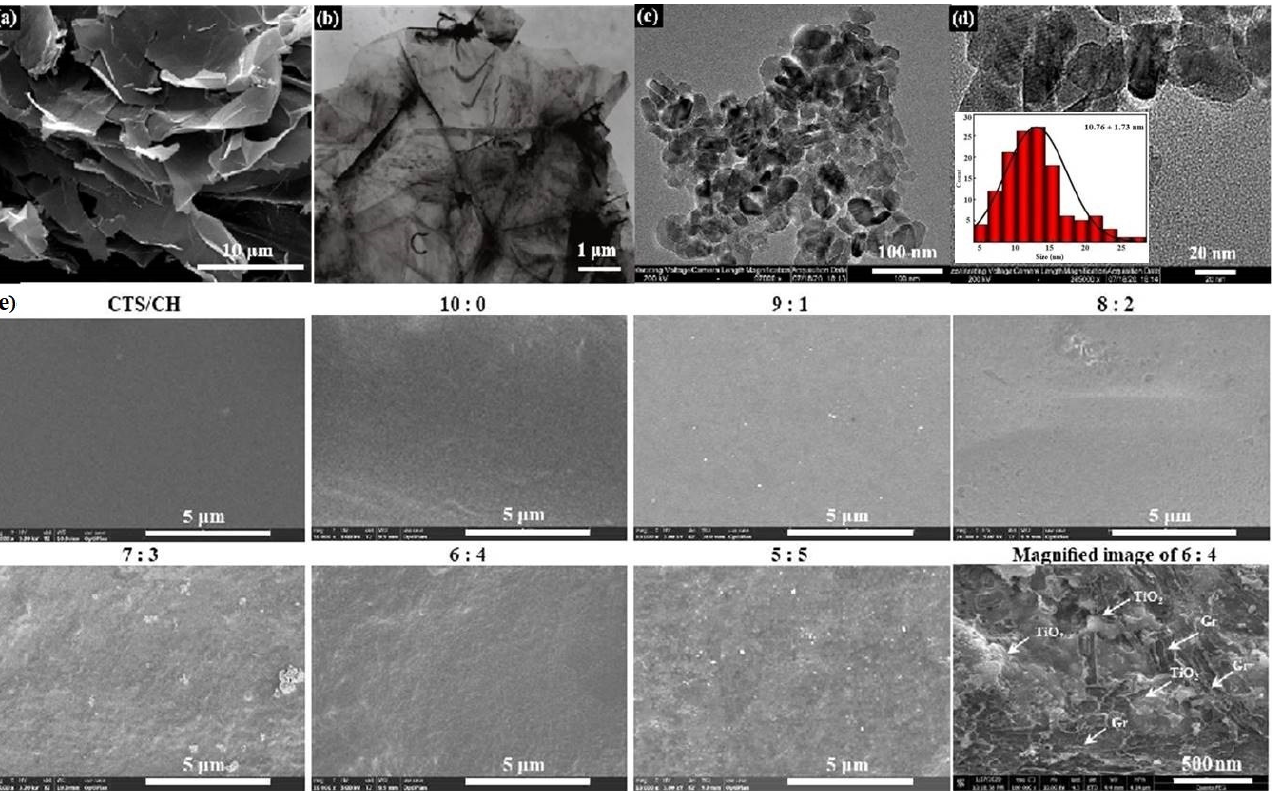
Figure 1. ( a ) SEM and ( b ) TEM images of Gr powder, ( c ) and ( d ) TEM images of TiO 2 NPs, and ( e ) typical SEM images of the different composite films fabricated at an ultrasonic power of 160 W. These results confirm the good dispersibility of TiO 2 NPs in the CTS/CSH matrix, while the zeta potential value of the precursor solution obtained at an ultrasonication power of 160 W was −14.33 ± 0.45 mV (Table 1). However, at a TiO 2 :Gr ratio of 9:1, the dispersion stability significantly decreased, and the precursor solution separated into three different layers: a clear upper layer, a lightly colored middle layer corresponding to a uniform CTS/CSH/TiO 2 /Gr dispersion, and a deeper colored lower layer containing precipitated TiO 2 /Gr particles. The relatively small amount of added Gr limits its expansion. This phenomenon caused a significant drop in the solution zeta potential to −10.31 ± 0.13 mV and decreased the stability of the system. Upon increasing the Gr content, the upper layer contained a very small amount of a clear liquid after 24 h of storage, while the black (due to the high Gr content) lower layer essentially consisted of the CTS/CSH/TiO 2 /Gr dispersion. The results revealed that the stability of the precursor solution toward a separation increased with an increasing Gr content, which was accompanied by the increase in its zeta potential values [17]. This behavior was attributed to the ability of Gr to undergo expansion in aqueous solutions and the wrapping of the TiO 2 NPs, thus increasing their dispersibility. Furthermore, the ultrasonic treatment strongly influenced the dispersion stability of the TiO 2 NP solution with TiO 2 :Gr = 6:4. The zeta potential value of this solution without the ultrasonic treatment was only − 8.40 ± 0.22 mV. As the ultrasonic power increased, the zeta potential value (absolute value) continuously increased to − 19.76 ± 2.28 mV. At high temperatures and pressures, the strong shock waves generated by the ultrasonic cavitation promoted the decomposition of the nanofiller aggregates into smaller aggregates, which were more uniformly dispersed in the system